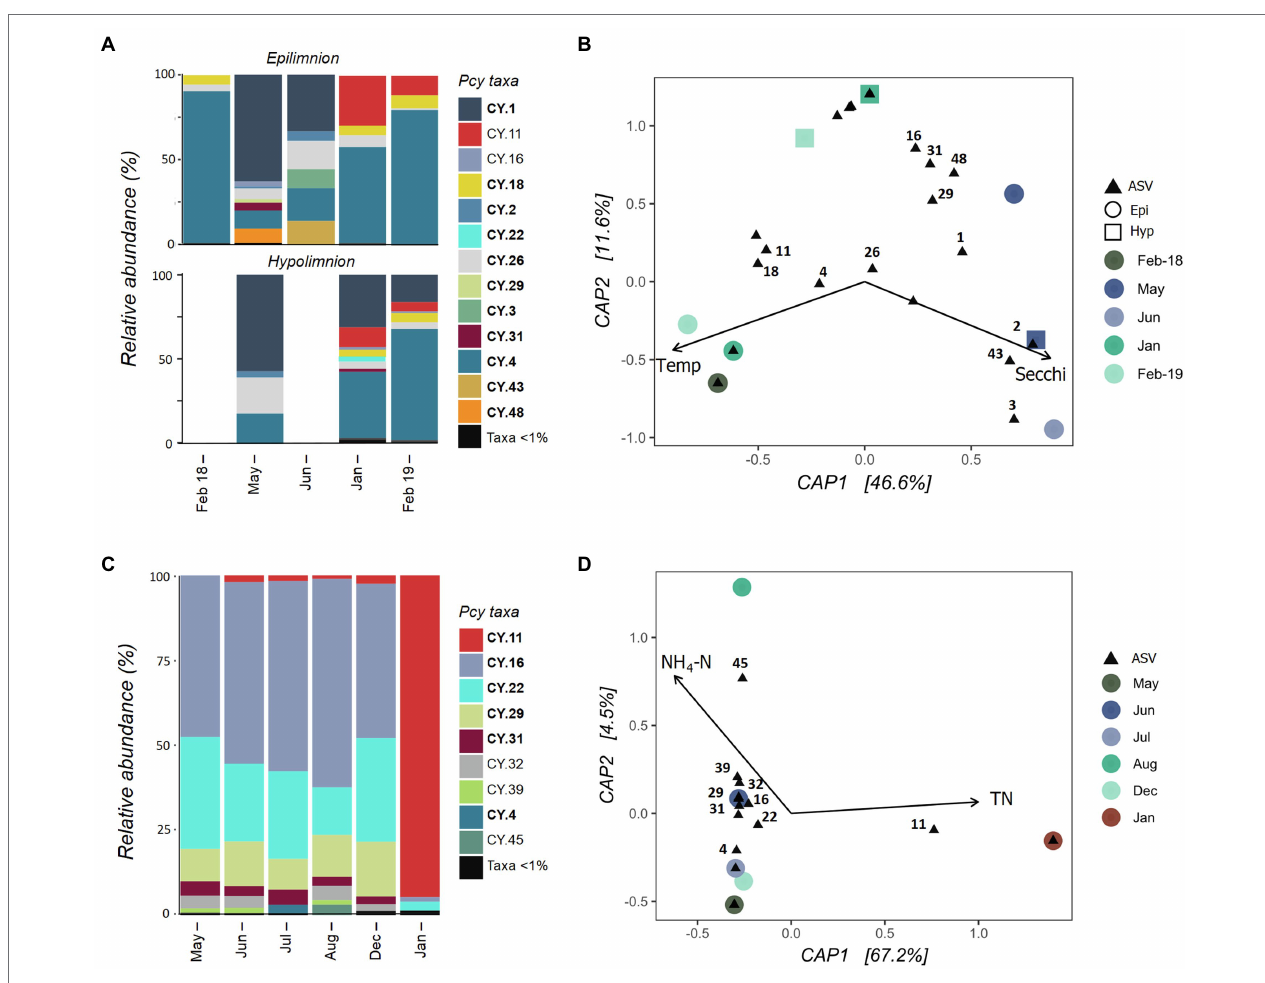
FIGURE 6 | Picocyanobacterial communities in Lake Hayes (A,B) and Tomahawk Lagoon (C,D) from February 2018 to February 2019. (A,C) show relative abundances of dominant picocyanobacterial amplicon sequence variants (ASVs) throughout the year with rare ASVs (>1% read abundance per sample) grouped together. Taxa labelled in bold indicate ASVs that are shared in at least one other study lake. Blank bars are due to insufficient cyanobacterial reads. (B,D) are canonical analyses of principal coordinates (CAP) with picocyanobacterial sample communities (circles are epilimnion samples, squares are hypolimnion samples) and ASVs (black triangles), constrained by selected environmental variables. Abundant ASVs (>1% abundant per sample) are numbered. Pcy, picocyanobacteria; TN, total nitrogen; and NH 4 -N, ammoniacal